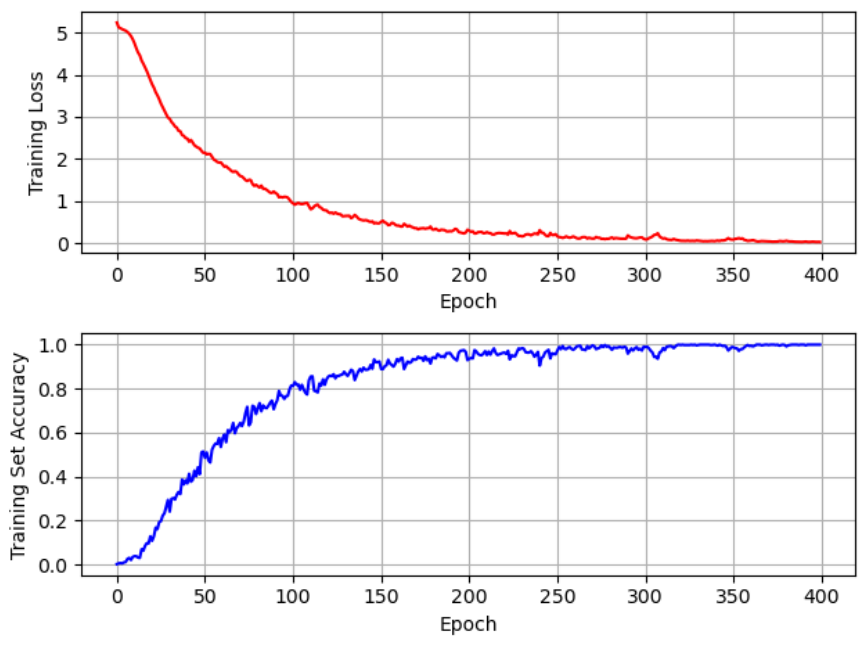
Figure 1. Training loss and training set accuracy of deep neural